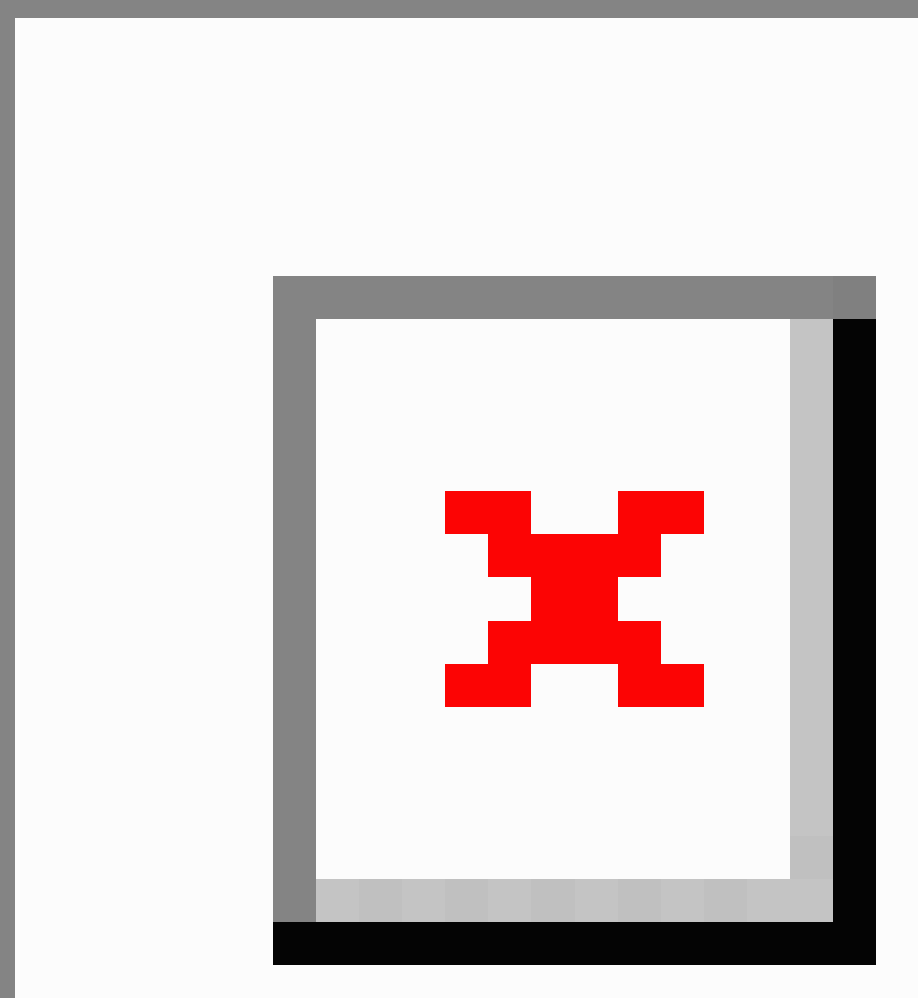
Figure 1. Flow of studies through the review according to PRISMA